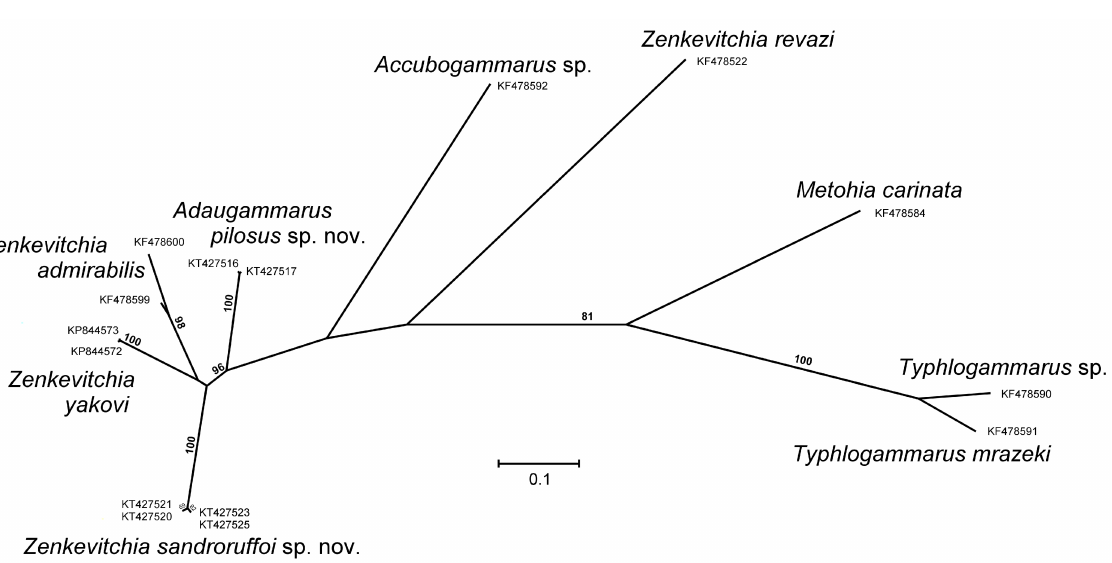
Fig. 3. Unrooted ML-tree with bootstrap support values based on the mt- cox1 sequences (values less than 50% not shown). Specimen labels refer to information given in Table S1. Scale bar indicates the number of substitutions per